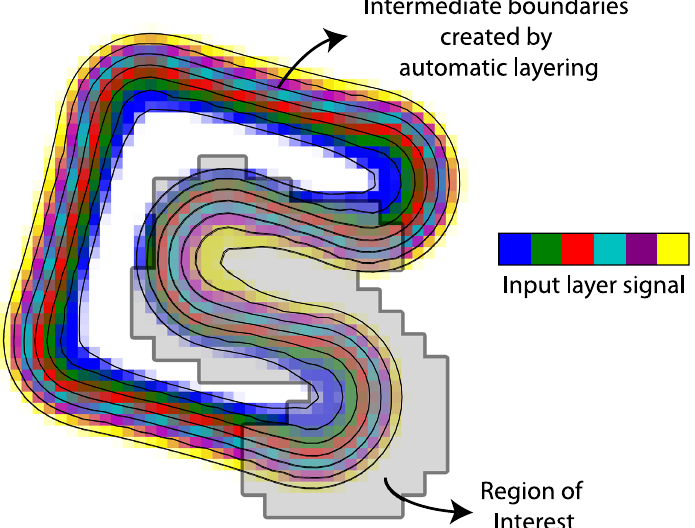
Fig 3. An equi-volume simulation of a cortex with six layers. The layers were resampled to a cubic voxel raster of [0.5mm] 3 resolution (shown here) and was later downsampled to [1.0 mm] 3 . Hence, each voxels contains a mixture of signal from different layers (illustrated by means of colours).